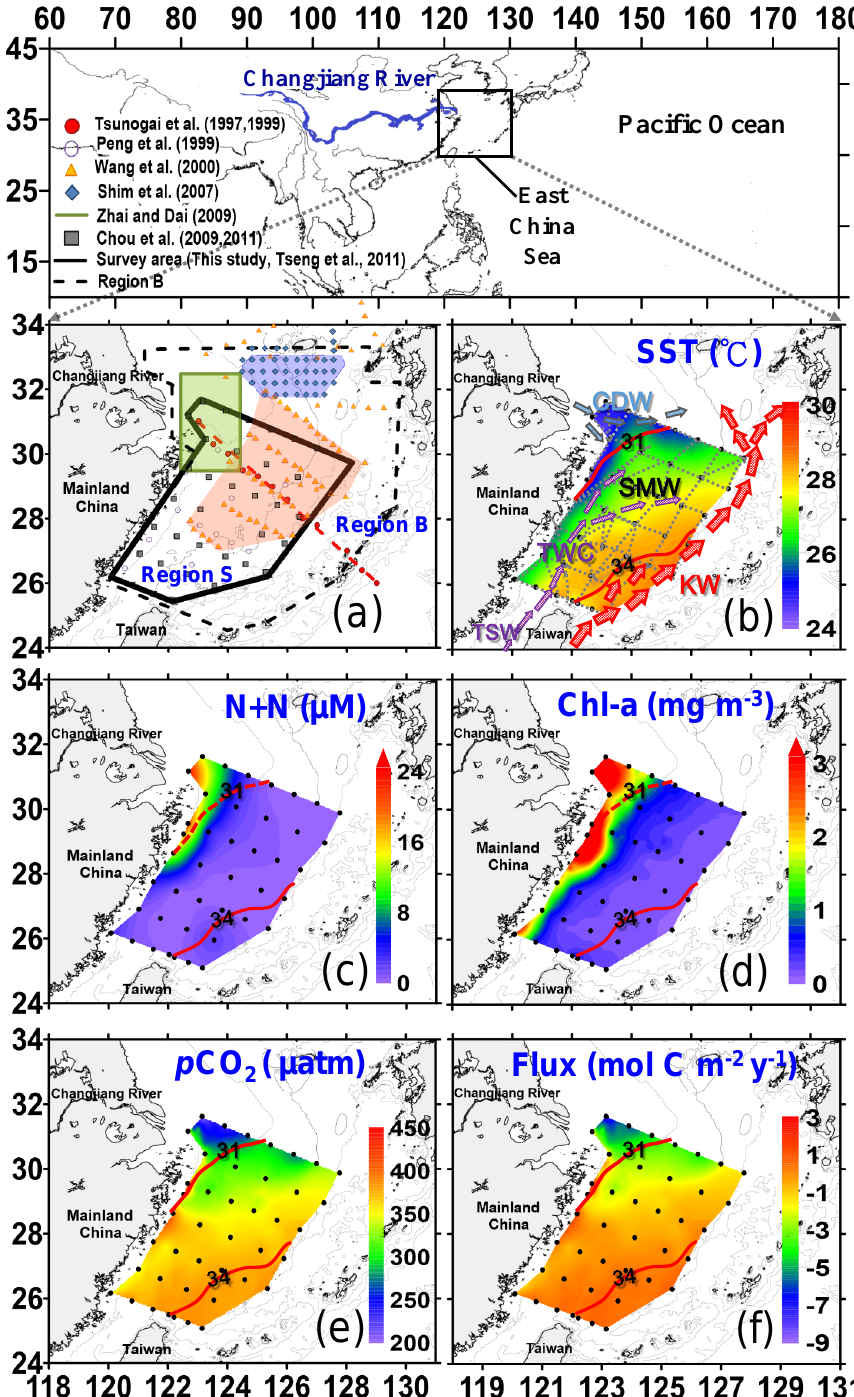
Figure 1. Maps of the study areas in the ECS showing (a) the previously published CO 2 -related studies (e.g., Tsunogai et al., 1997, 1999; Peng et al., 1999; Wang et al., 2000; Shim et al., 2007; Zhai and Dai, 2009; Chou et al., 2009, 2011; Tseng et al., 2011). The surveyed area of Tseng et al. (2011) and this study is Region S. The area outlined by dashed line for modeled synthesis is Region B. (b) Hydrographic stations (black dots) and cruise track of the underway p CO 2 measurements (dashed line) with SSS and SST contours and circulation patterns in the ECS in summer. KW – Kuroshio Water; TSW – Taiwan Strait Water; TWC – Taiwan Warm Current, SMW – Shelf Mixed Water; CDW – Changjiang Diluted Water. (c) The composite distributions of surface water nutrient (N+N); (d) chlorophyll a (Chl a ); (e) p CO 2 ; and (f) air–sea CO 2 exchange flux observed between August 2003 and July 2011 aboard R/V Ocean Research-1 (OR1)